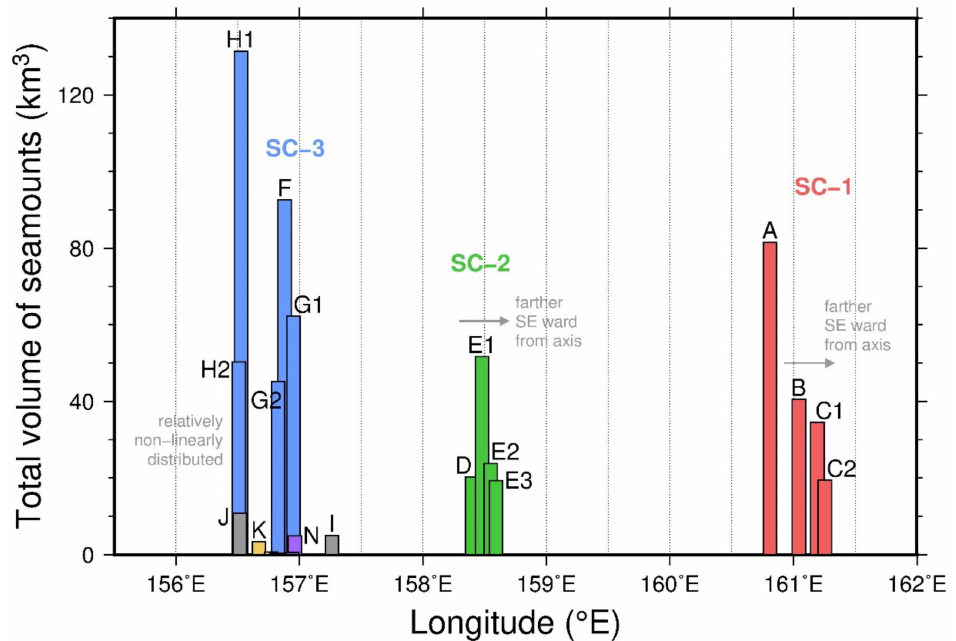
Figure 6. Longitudinal distribution and volume of seamounts along the KR1 segment. The major seamount chains of SC-1, SC-2, and SC-3 are shown in red, green, and blue bars, respectively, and the smaller seamounts distributed near SC-3 in the west of KR1 are marked in other colors.